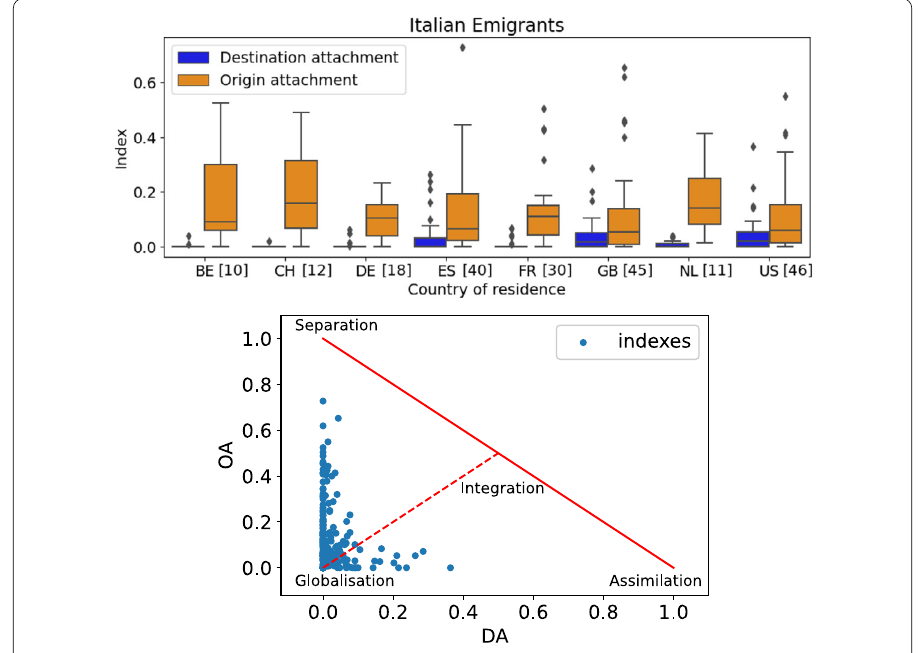
Figure 9 Top: Box plots for DA and OA for Italian nationals living abroad. Countries on x -axis are countries of residence of Italians. Bottom: Scatter plot of OA vs. DA indicating approximate integration types for Italian